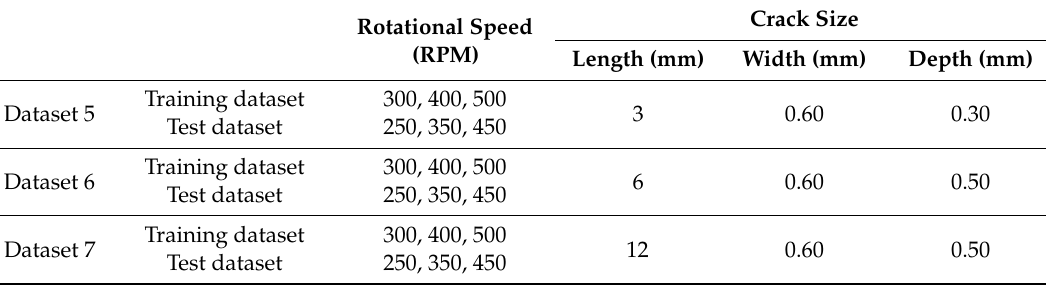
Table 3. Dataset for compound bearing